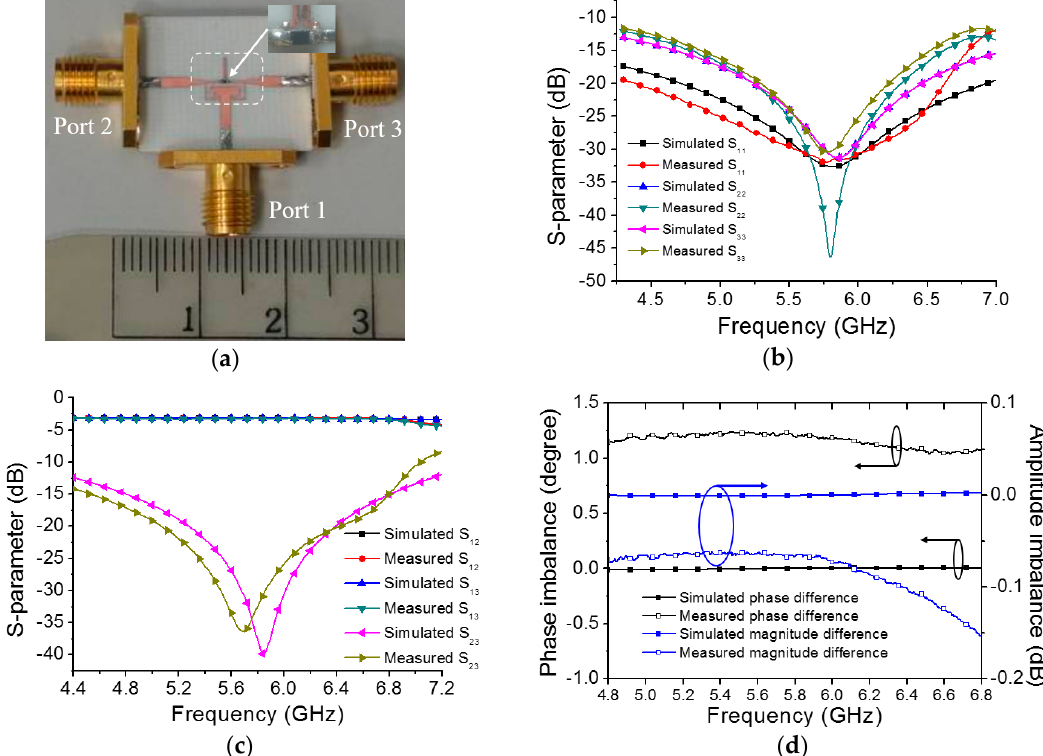
Figure 7. ( a ) The photo; ( b ) measured and simulated S 11 ,S 22 ,S 33 ; ( c ) measured and simulated S 12 ,S 13 ,S 23 ; ( d ) measured and simulated phase and amplitude imbalance of the fabricated prototype at 5.8 GHz. Table 2. Performance comparison of the two prototypes with previous published works.